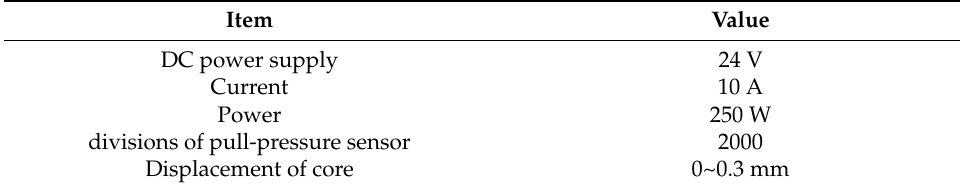
Figure 7. HFSV electromagnetic force test bench. Table 2. Specifications of the experimental system.